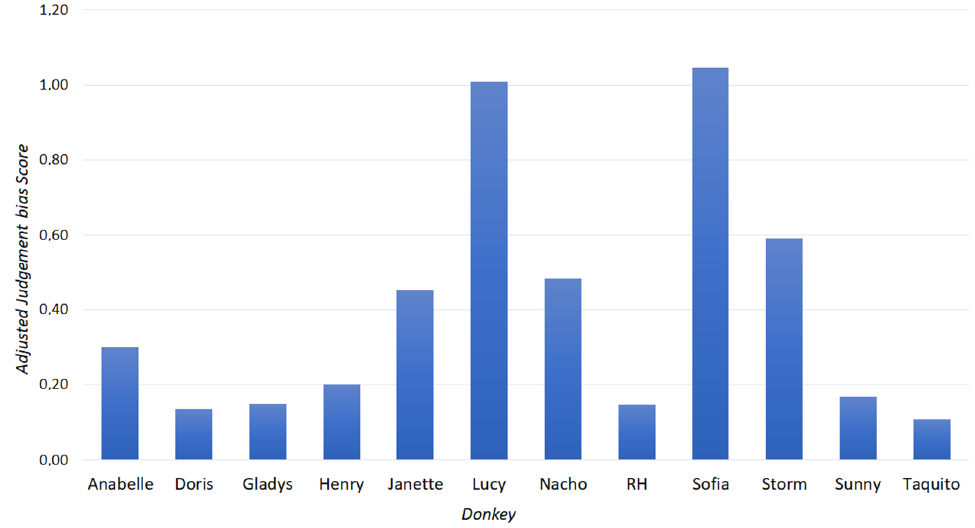
Figure 2. Adjusted judgement bias score (calculated mean latencies to approach the ambiguous stimulus—An, during treatment phase of the judgement bias test). Individuals that approach the stimulus more promptly have lower scores.